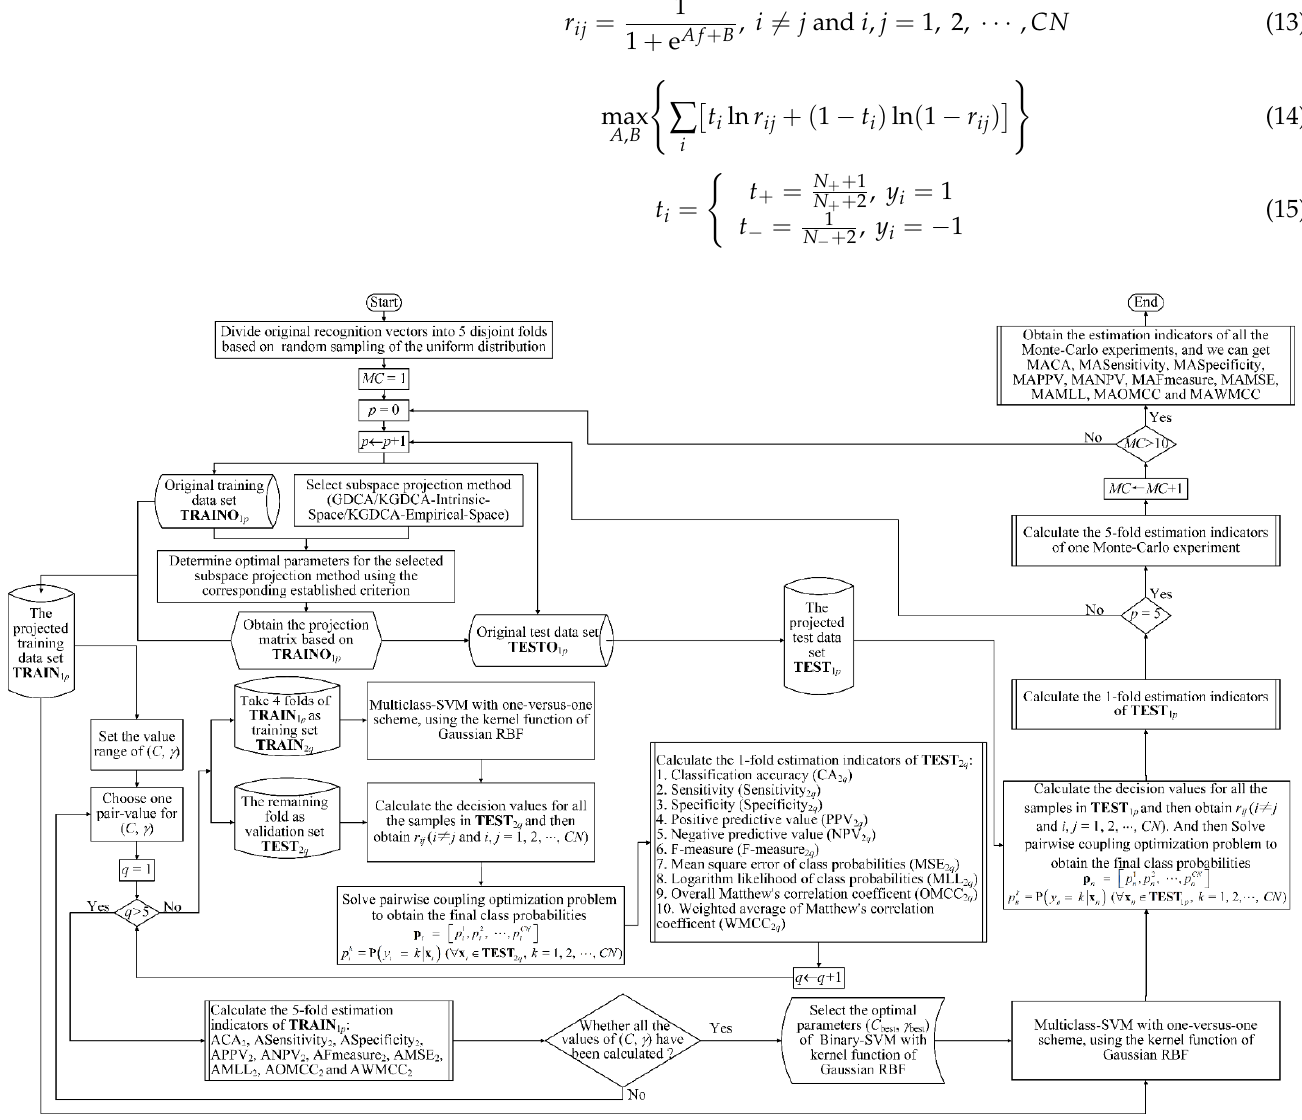
Figure 10. Test strategy of the newly proposed pattern recognition by combining Monte-Carlo experiment with cross-validation.